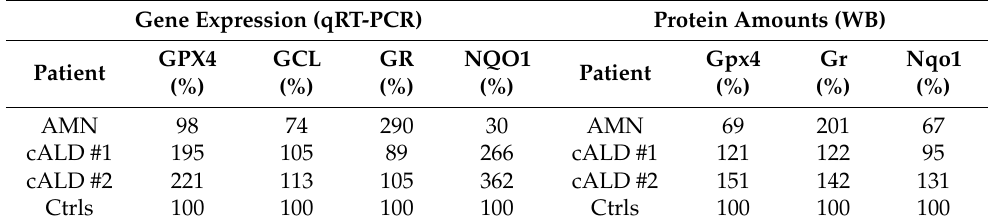
Table 2. qRT-PCR and Western blot results expressed as percentage respect to healthy subjects (Ctrls). Gene Expression (qRT-PCR) Protein Amounts